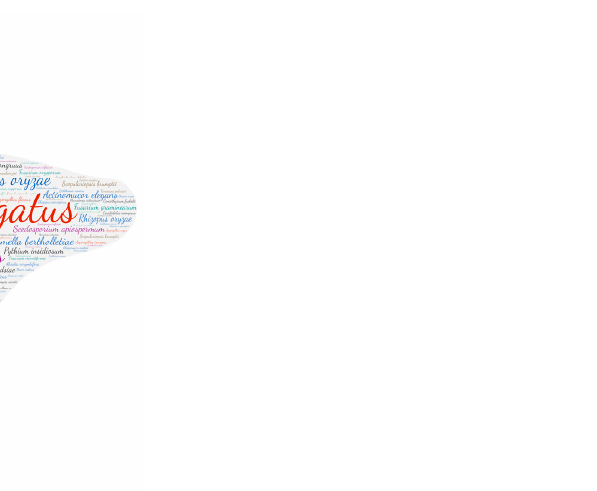
Figure 10. Wordcloud represents the species name isolated in the liver. The size of the name of each species is proportional to the number of times it occurs in the repertoire.